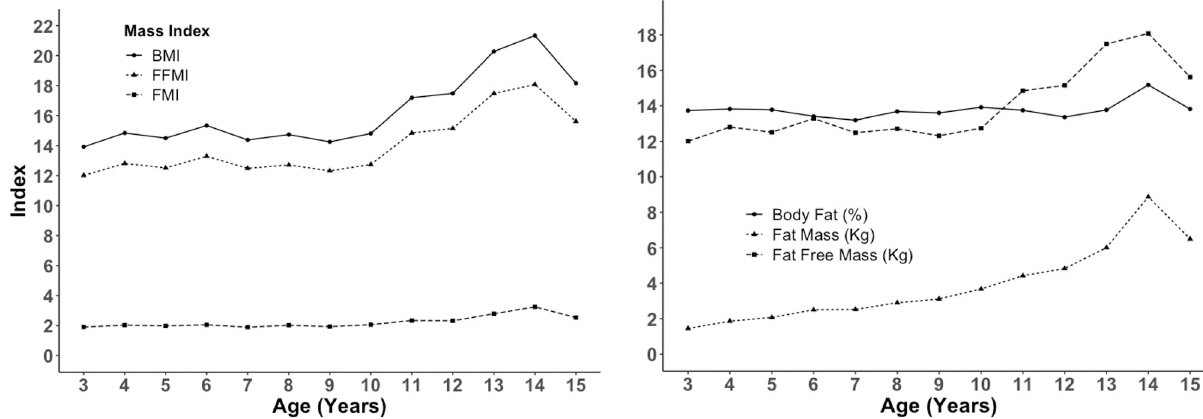
Fig 2. Trajectories of BMI, FFMI and FMI plotted against age in year (n = 330).